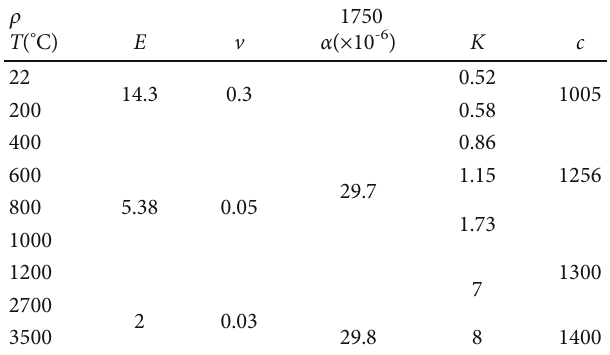
Table 3: Material properties of